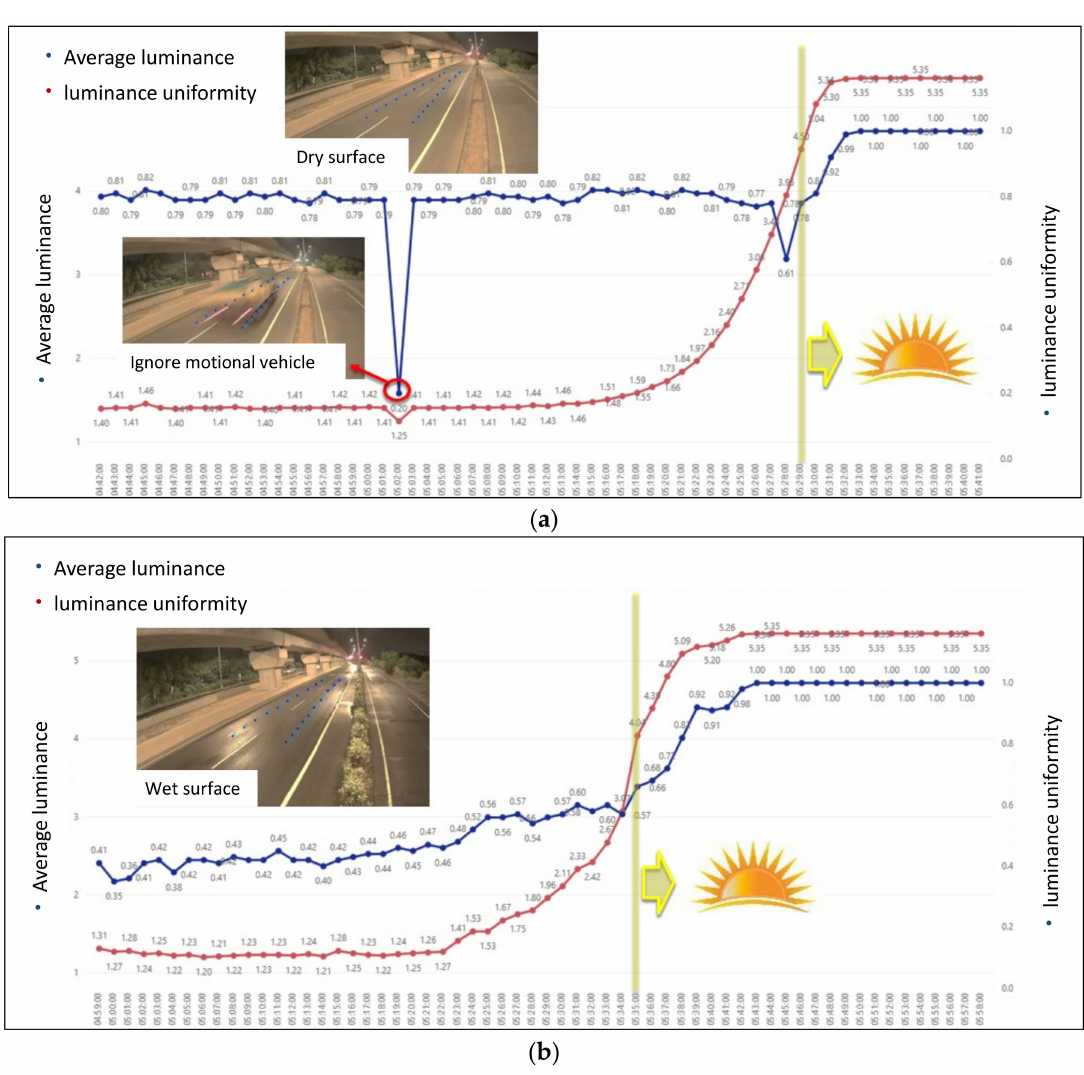
Figure 22. The luminance level in Sect. 5 of Gaotie South Road: ( a ) dry surface; ( b ) wet surface. According to the records of road luminance uniformity by the ILM from September, we collected the highest and lowest value per day from 19:00–04:00. The standard deviations are shown in Table